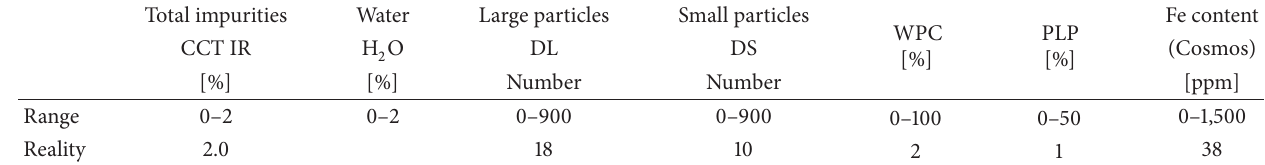
Table 8: The measurement results for sample E.